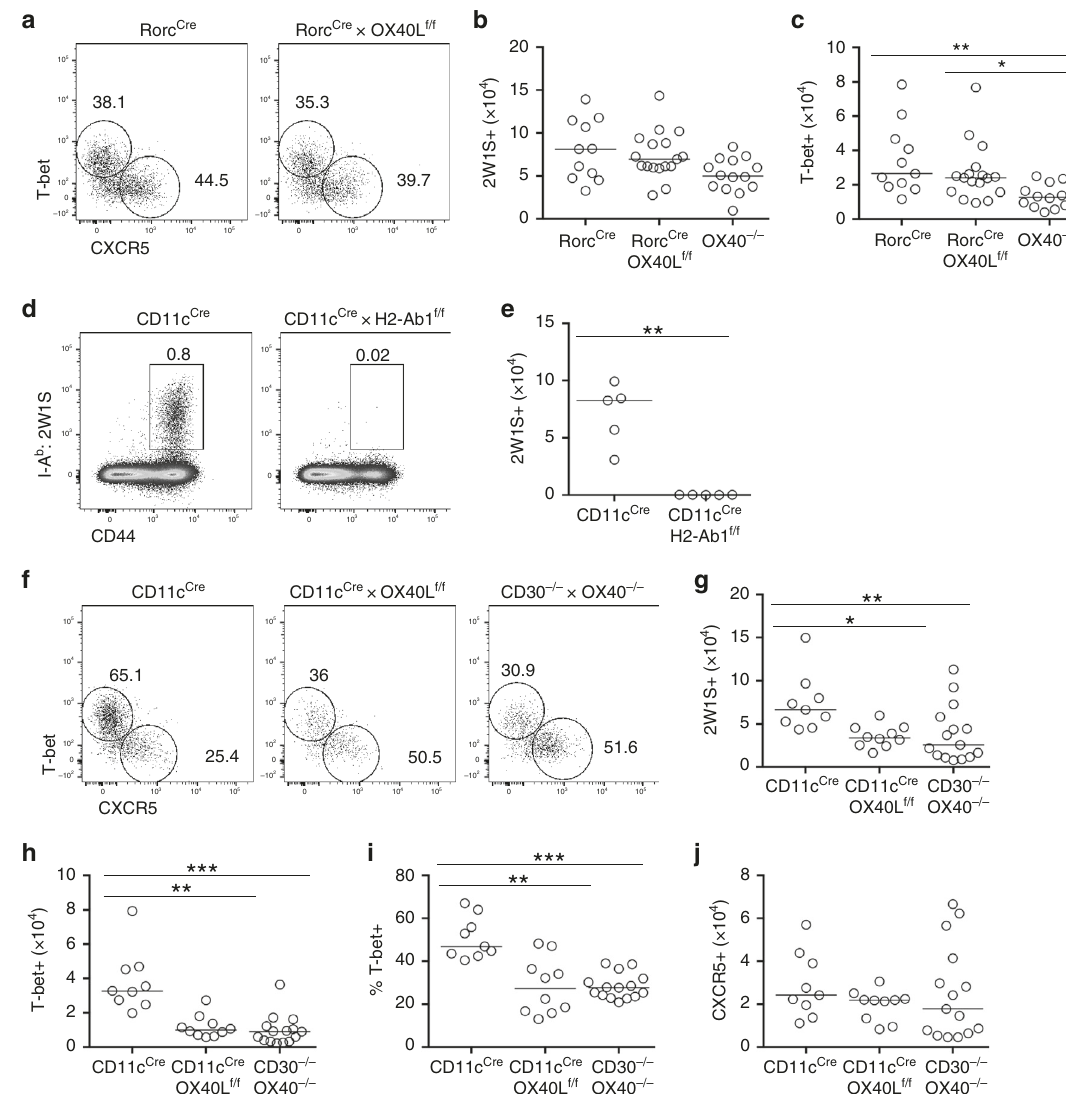
Fig. 3 Expression of OX40L by DC is required for effector Th1 responses. To investigate the critical cellular interaction for generation of Th1 effector T cells, conditional OX40L-de fi cient mice targeting ILC3s (Rorc cre ) or DCs (CD11c cre ) were generated. a Expression of T-bet versus CXCR5 by 2W1S- speci fi c CD44 hi CD4 T cells in Rorc cre and Rorc cre × OX40L f/f mice. b Enumeration of CD44 hi 2W1S-speci fi c CD4 T cells in Rorc cre , Rorc cre × OX40L f/f and OX40 − / − control mice. c Enumeration of T-bet + 2W1S-speci fi c CD44 hi CD4 T cells in Rorc cre , Rorc cre × OX40L f/f and OX40 − / − control mice. Data were pooled from 3 independent experiments ( n = 11 Rorc cre mice, n = 17 Rorc cre × OX40L f/f mice, n = 14 OX40 − / − mice). d Representative fl ow cytometric plots showing CD44 hi 2W1S-speci fi c CD4 T cells in the spleen of CD11c cre and CD11c cre × H2-Ab1 f/f mice at 7 days post infection. e Enumeration of CD44 hi 2W1S-speci fi c CD4 T cells. Data are representative of 2 independent experiments, n = 5 mice per group. f Expression of T-bet versus CXCR5 by 2W1S- speci fi c CD44 hi CD4 T cells in CD11c cre , CD11c cre × OX40L f/f and CD30 − / − × OX40 − / − mice. g Enumeration of 2W1S-speci fi c CD44 hi CD4 T cells. h Enumeration of T-bet + 2W1S-speci fi c CD44 hi CD4 T cells. i Percentage of 2W1S-speci fi c CD4 T cells expressing T-bet. j Enumeration of CXCR5 + 2W1S-speci fi c CD44 hi CD4 T cells. Data were pooled from 3 independent experiments ( n = 9 CD11c cre mice, n = 10 CD11c cre × OX40L f/f mice, n = 15 CD30 − / − × OX40 − / − mice). Values on fl ow cytometric plots represent percentages; bars on scatter plots represents the median. Statistical signi fi cance was tested in e by using an unpaired, non-parametric, Mann – Whitney two-tailed T test and in b , c , h – j by using Kruskal – Wallis one-way ANOVA with post hoc Dunn ’ s test: * p ≤ 0.05, ** p ≤ 0.01, *** p ≤